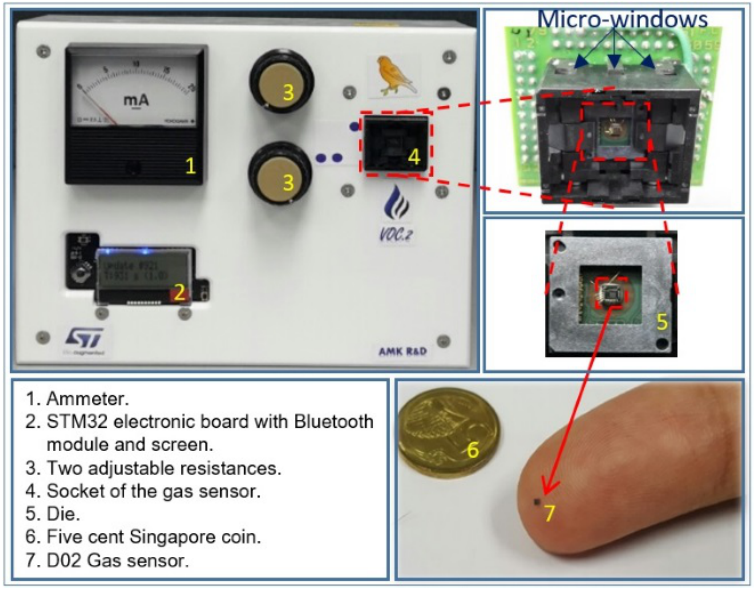
Figure 13. Canary board along with its different